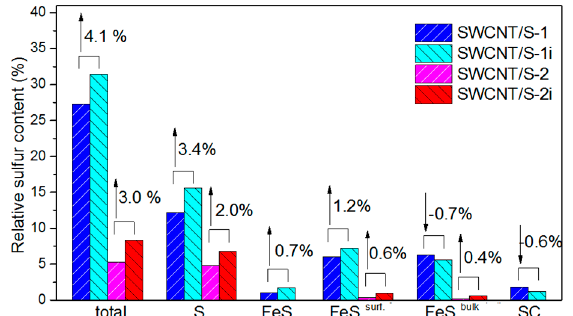
Figure 5. S K -edge NEXAFS spectra of SWCNT / S-1 and SWCNT / S-2 samples ( a ). S 2 p XPS spectra of sulfur-contained SWCNTs before and after illumination ( b ) and ( c ). Normalized S 2 p XPS spectra of SWCNT / S-2 and SWCNT / S-2i samples and their di ff erence ( d ).